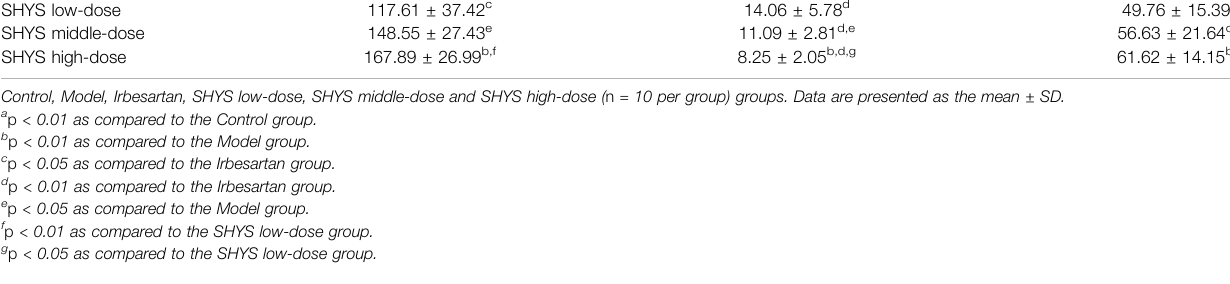
Frontiers in Pharmacology |